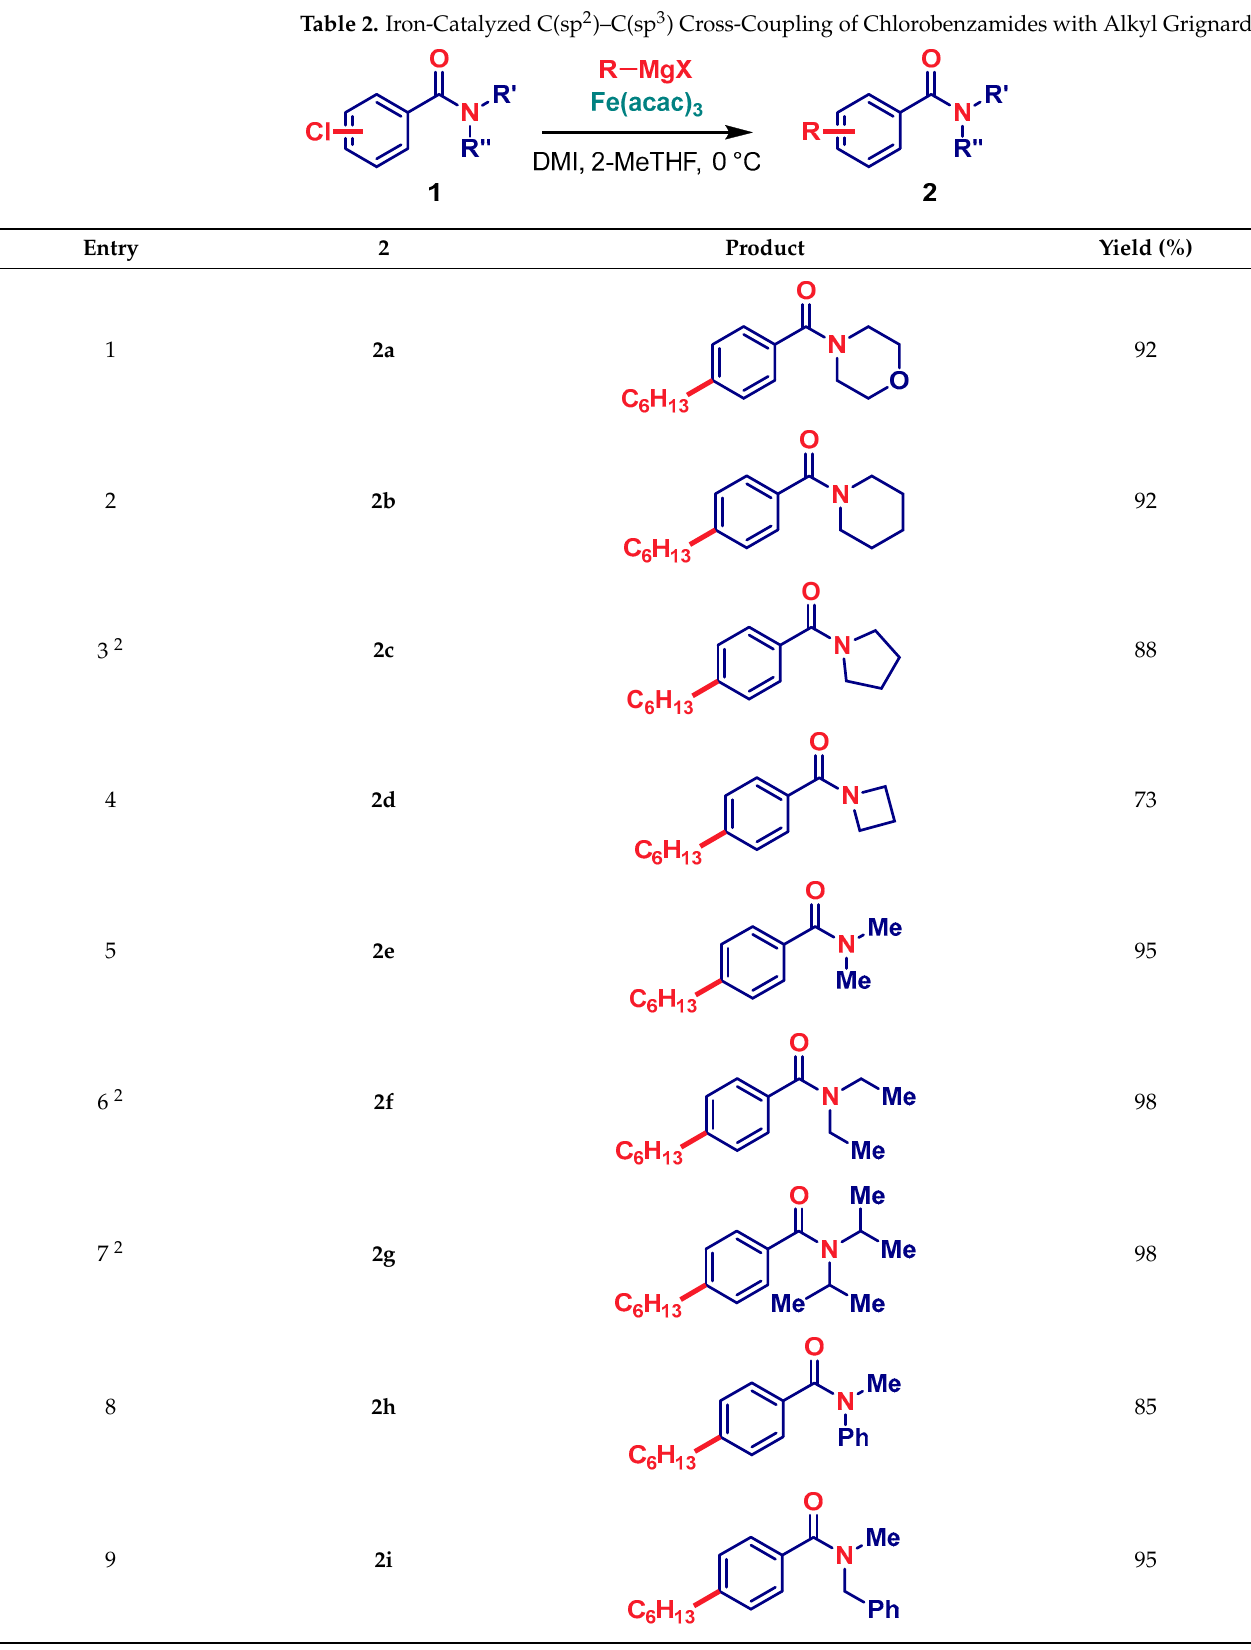
Table 2. Iron-Catalyzed C(sp 2 )–C(sp 3 ) Cross-Coupling of Chlorobenzamides with Alkyl Grignards 1 .